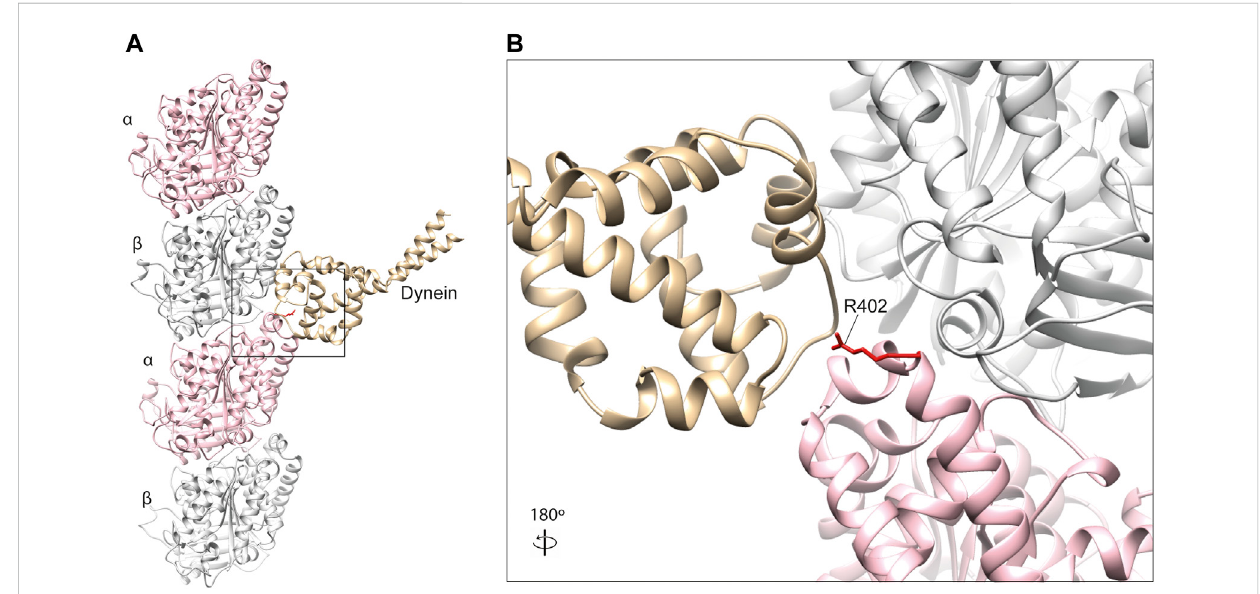
FIGURE 4 (A) Insilico homologymodel ofa microtubule proto fi lament with bound dynein. α -tubulinsarerepresented by apinkribbon, β -tubulinsinsilverand dynein microtubule-binding domain in gold (PDB 3J1T) (Redwine et al., 2012). (B) A detailed view of the dynein-interacting domain. The R402 residue of α -tubulin (red) is a hot-spot for pathogenic variants in TUBA1A, which have been shown to affect dynein interaction and processivity (Aiken et al., 2019; Leca et al.,